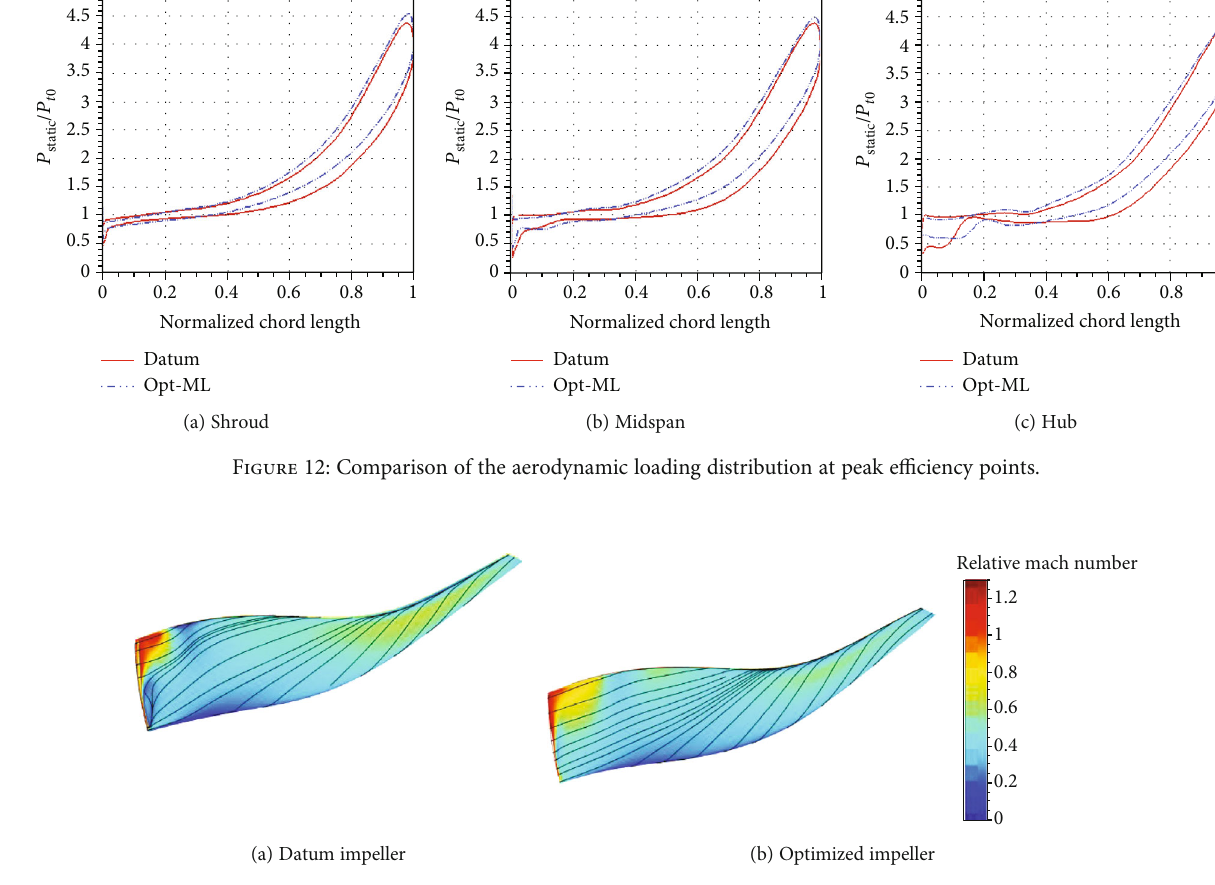
Figure 13: Streamlines and relative Mach number comparison.